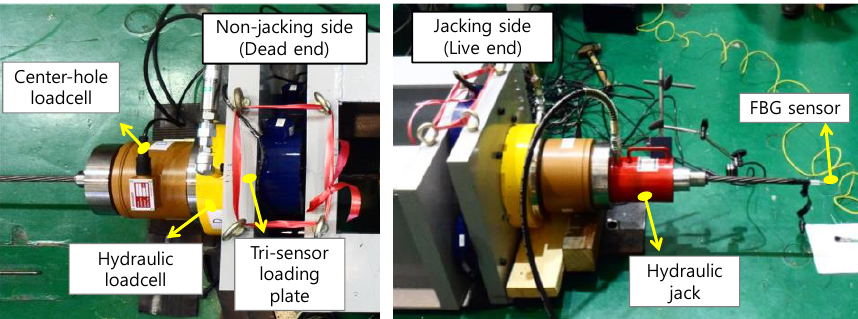
Figure 2. Steel frame of a girder for validation test (not to scale, stiffeners not shown).